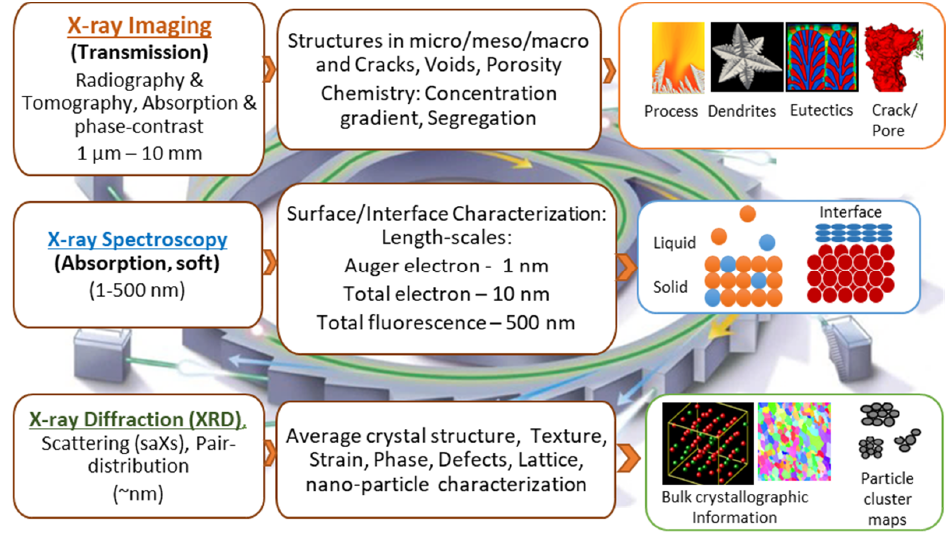
Figure 1. Some of the important synchrotron X-ray based, in situ, and operando characterisation techniques for metals, their scales, capabilities, and examples (adapted from Bak et al.,